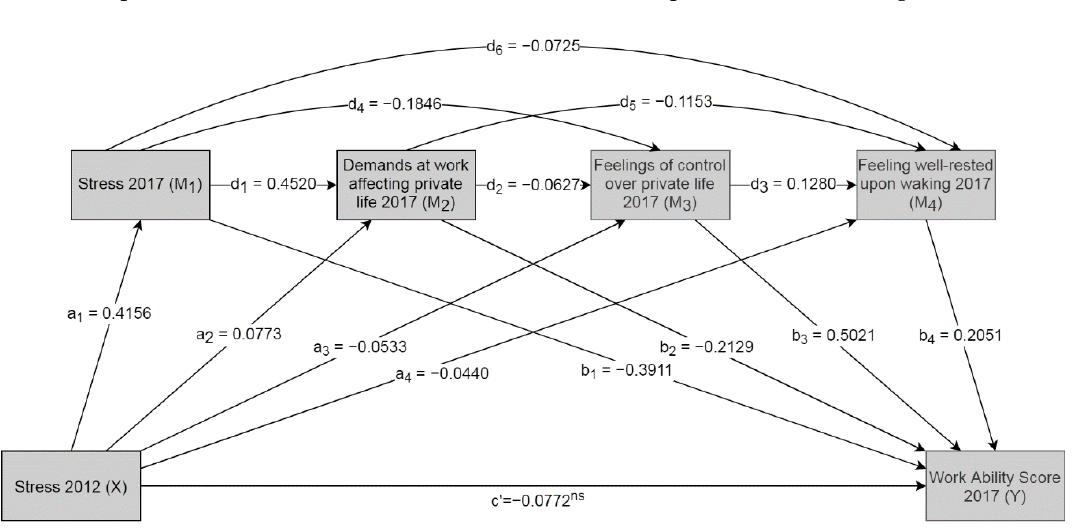
Table B3: Direct and indirect effects for mediating pathways for males of the relationship between stress in 2012 and work ability in 2017 in a parallel design ( n = 575).